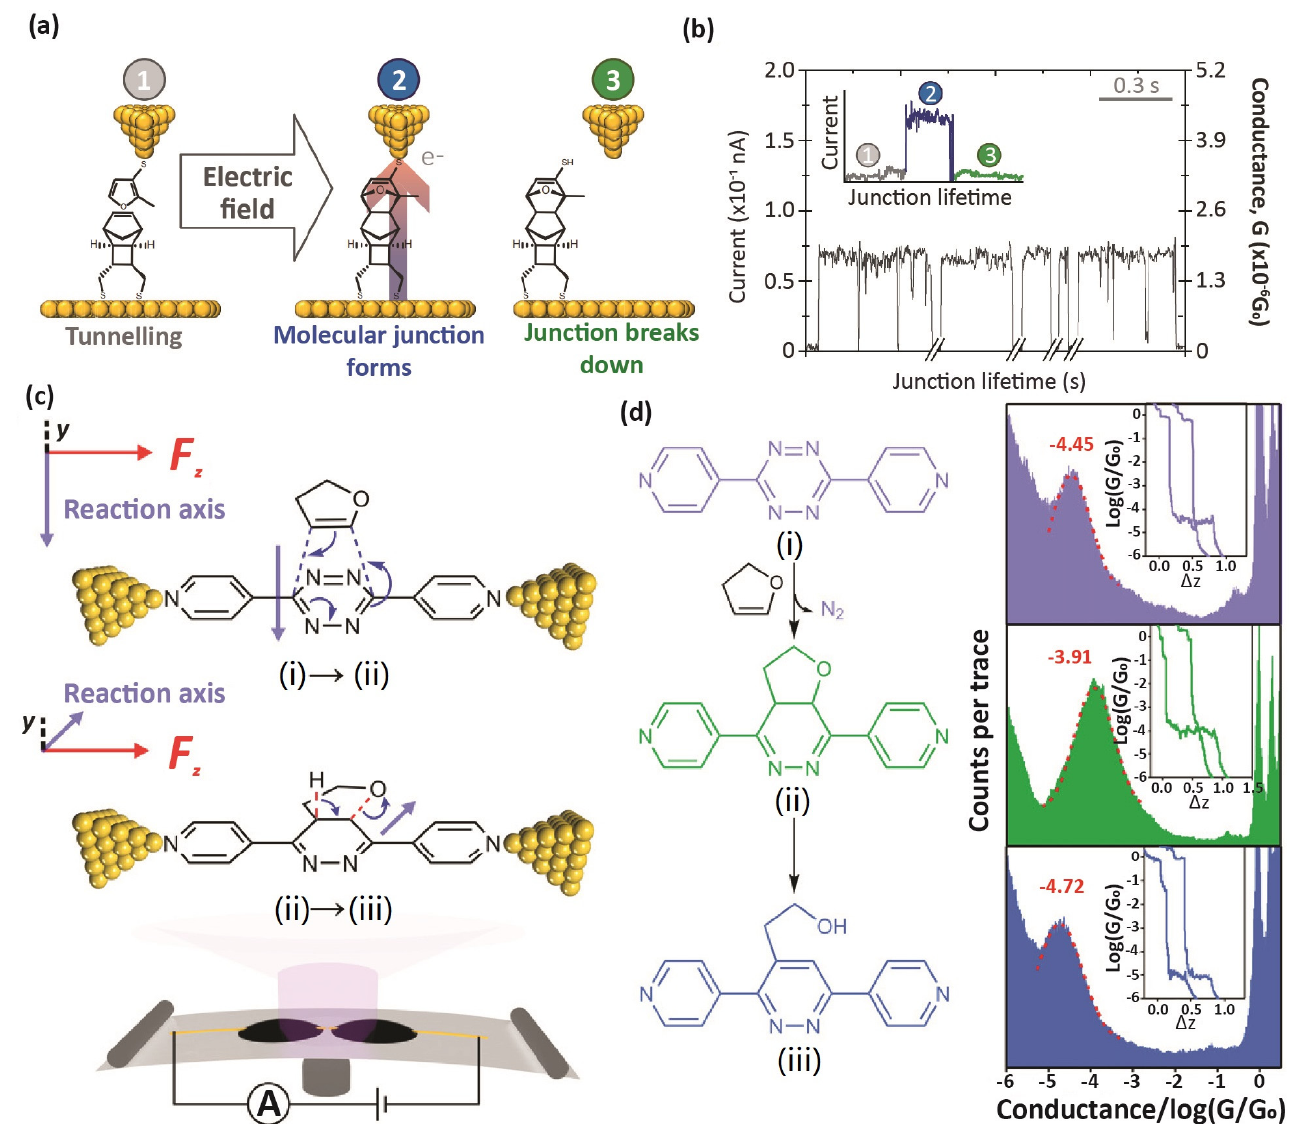
Figure 2. Electric-field-driven Diels–Alder reaction ( a ) Schematics of the STM tip approach and retract stages of the blinking junction. Label 1 corresponds to a diene and a dienophile reactant attached to a Au tip and substrate before reaction, 2 corresponds to the product of the reaction in 1, and 3 corresponds to the retraction stage where the junction breaks down. ( b ) The real-time current signal of the Diels–Alder reaction shown in ( a ). The inset corresponds to an arbitrary trace of 1, 2, and 3. Figures were reproduced with permission from reference [30]. Copyright 2016, Springer Nature. ( c ) A single-molecule Diels–Alder reaction in MCBJ. The direction of the electric field, F z (red arrow), is orthogonal to the reaction axis (blue arrow) and parallel to the y -axis. ( d ) Stages of the Diels–Alder reaction and their corresponding conductance plateau: ( i ) (10 − 4.45 G 0 ) corresponds to the reaction of furan and a dienophile to form ( ii ) (10 − 3.91 G 0 ), which also forms ( iii ) (10 − 4.72 G 0 ) after aromatization. Figures were reproduced with permission from reference [45]. Copyright 2019, Science